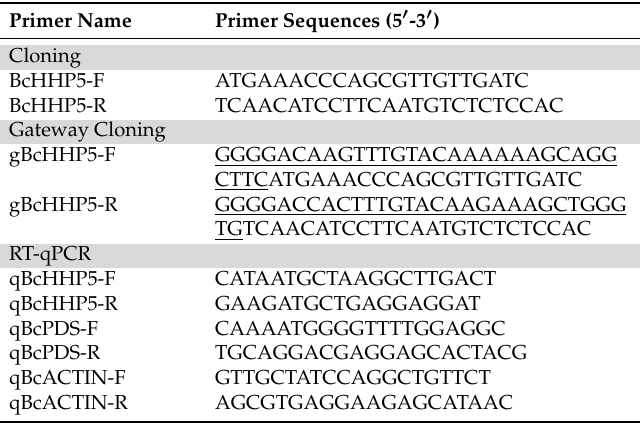
Table 1. Primer sequences used in this study.